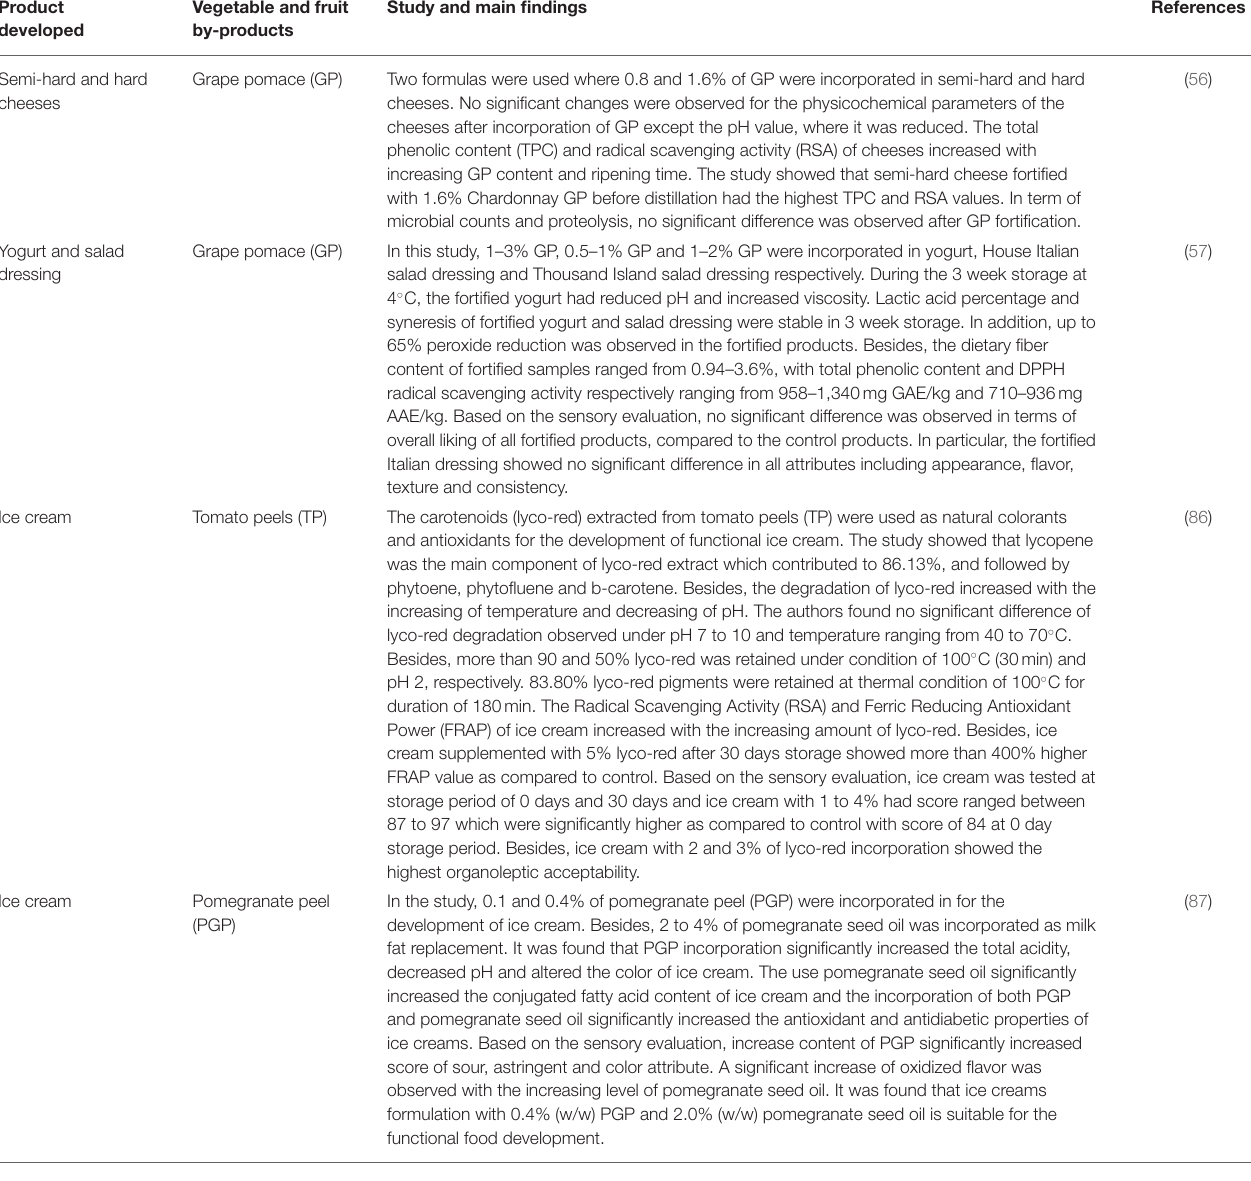
TABLE 4 | Study and main findings of vegetable and fruit by-products utilization as functional ingredients in development of dairy